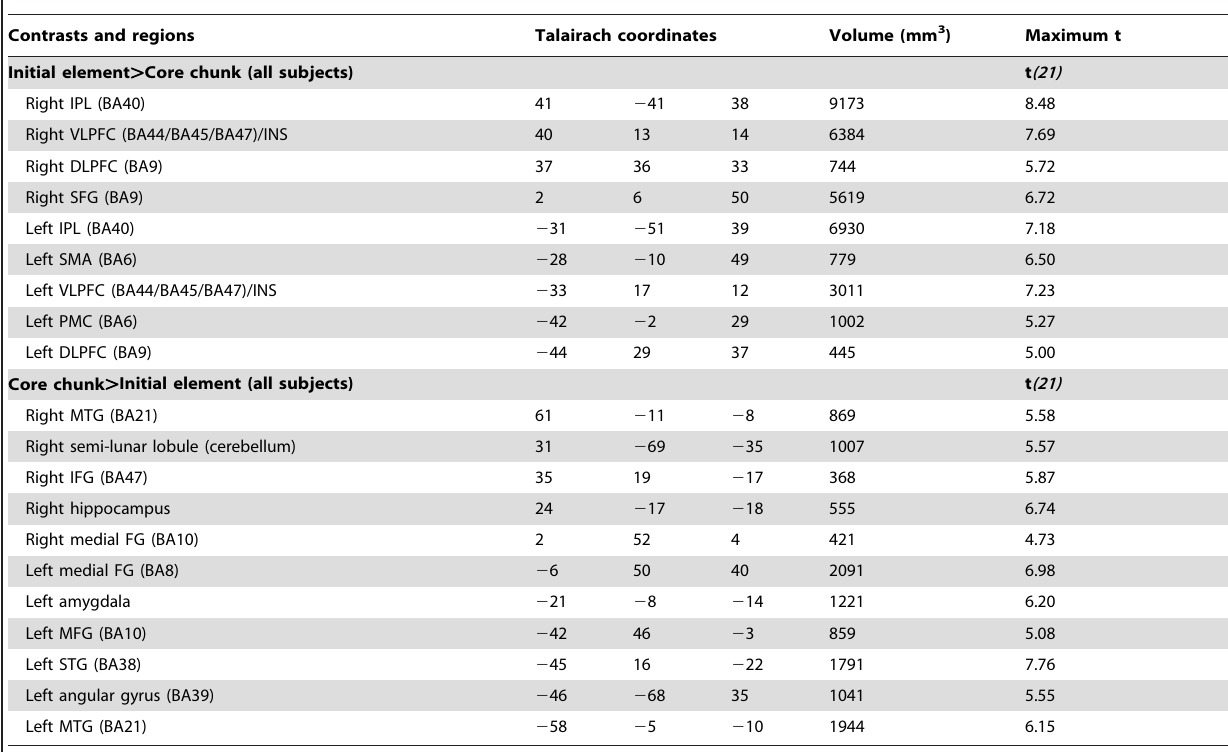
Table 3. Brain regions activated in both groups by contrasts [ Initial element . Core chunk ] and [ Core chunk . Initial element ].